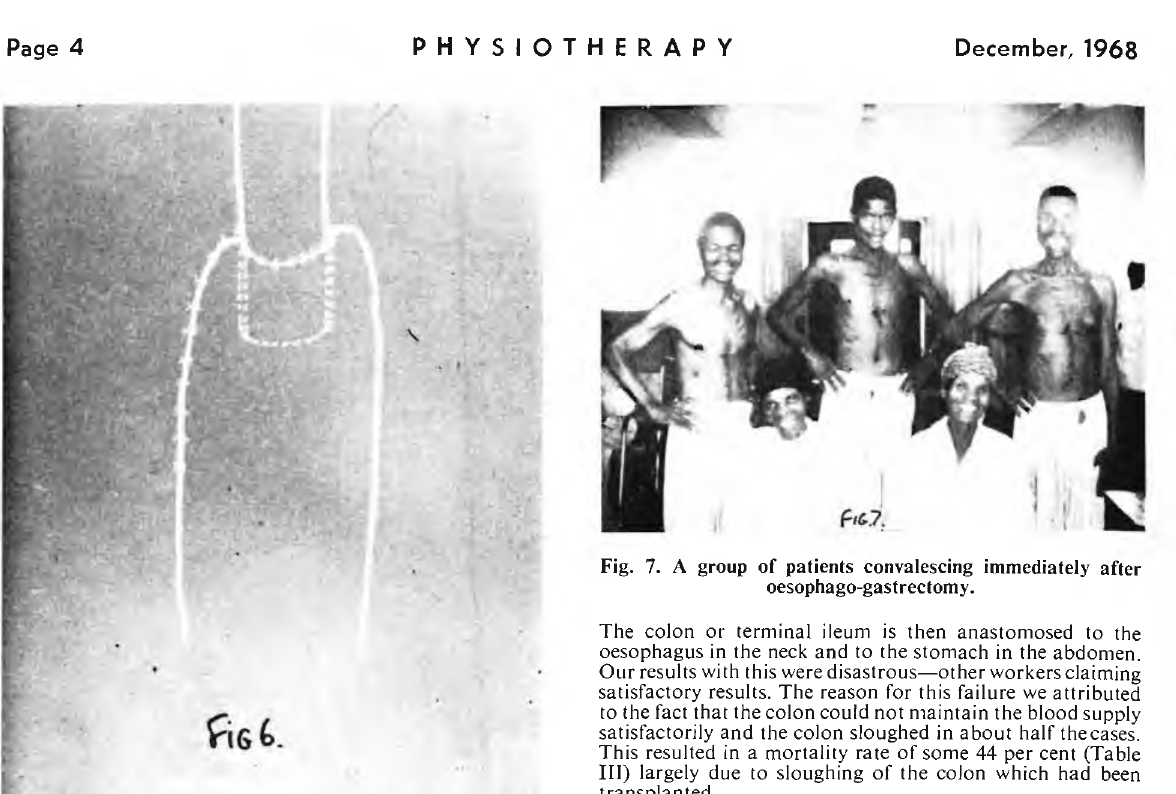
Fig. 6. A diagrammatic representation of the “inkwell” anastomosis.